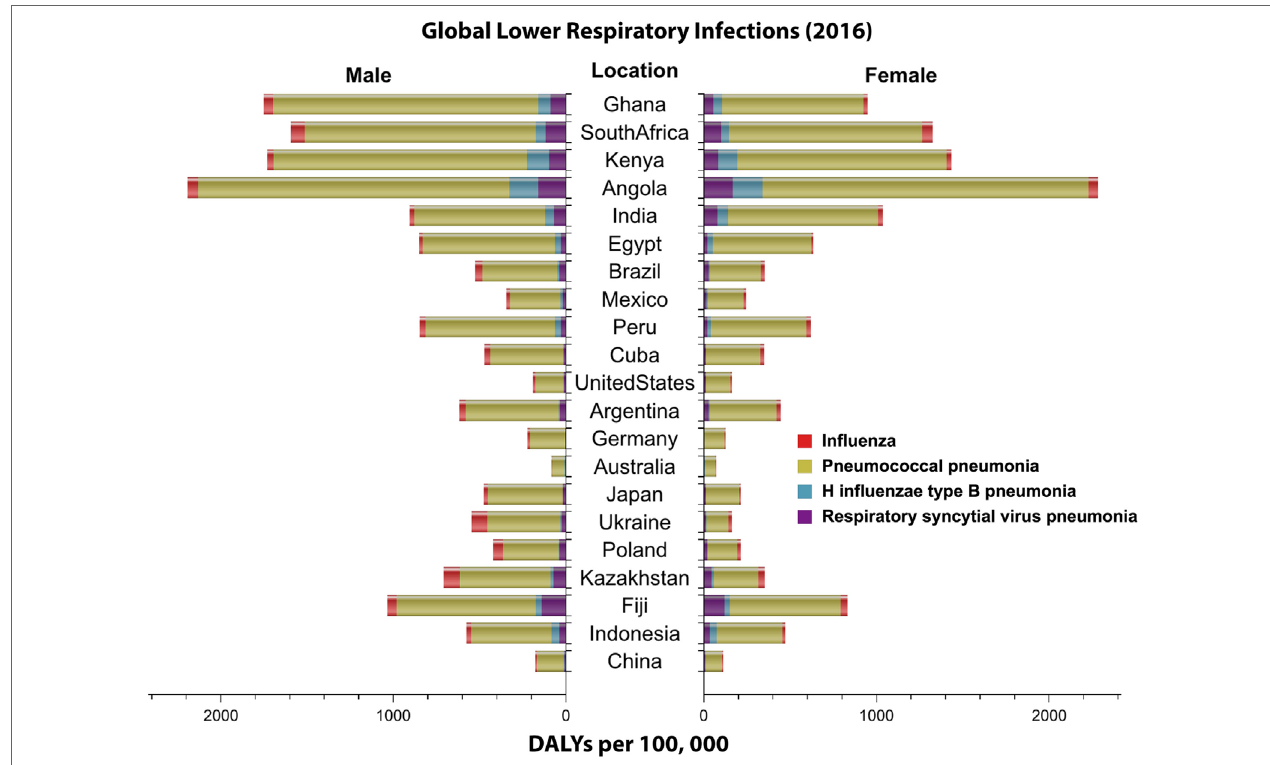
FigURe 1 | Global distribution of lower respiratory infections by sex. Highlighted in this figure is the distribution of the disability adjusted life year (DALY) per 100,000 (2016) for four major lower respiratory infections worldwide by sex. Data obtained from Institute for Health Metrics and Evaluation